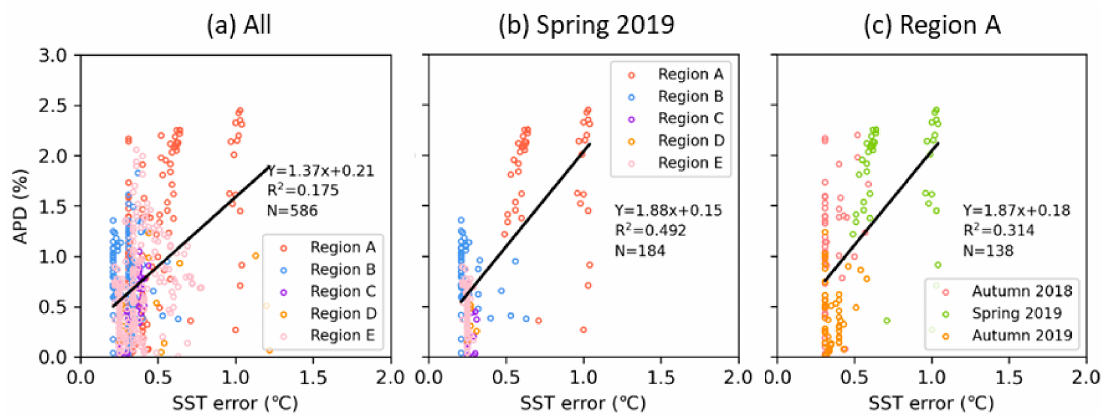
Figure 9. The highest correlations observed between the SST error (OSTIA product) and the APD of each matchup (|satellite– in situ |). Data: ( a ) whole set of cruises, ( b ) Spring 2019, and ( c ) region